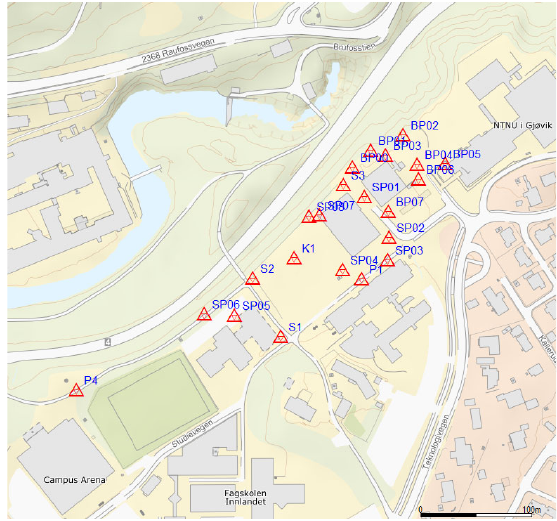
Figure 1 . Network at NTNU Gjovik